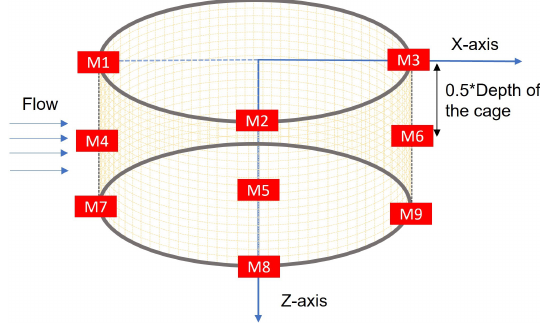
Figure 6: Coordinate system of the net cage model; the M1 to M9 in the red squares are the locations of the nine markers on the cage.